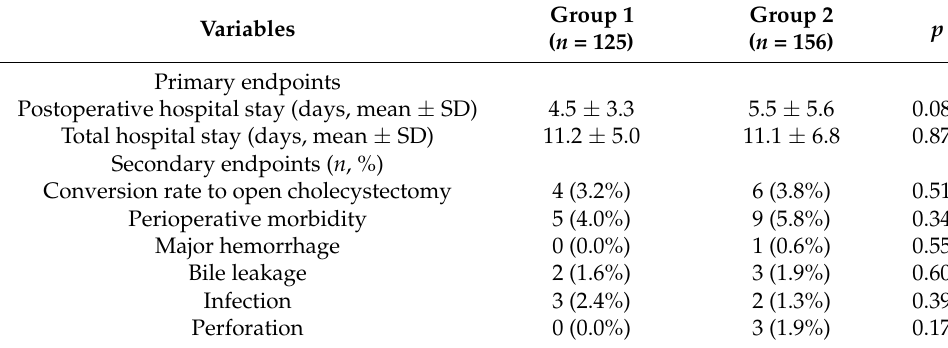
Table 2. Comparison of primary and secondary endpoints between the two